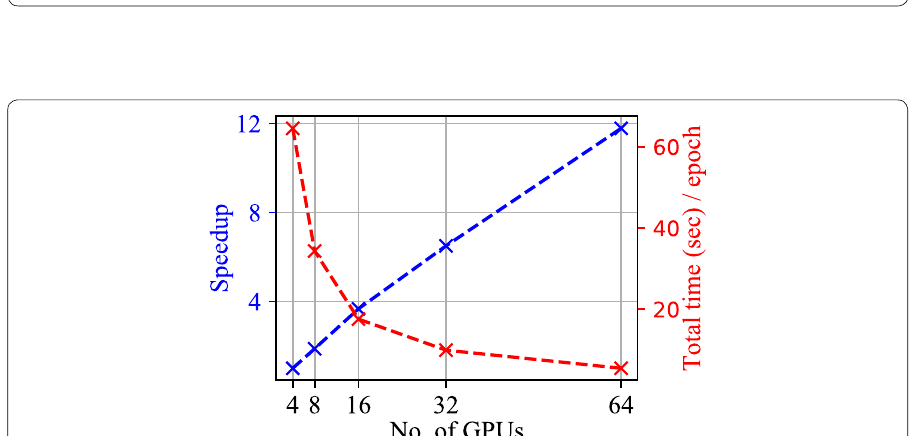
Fig. 4 Cosmology with the HAL Deep Learning Cluster The training stage of a deep learning model, used to morphologically classify galaxies between spiral and elliptical classes, is reduced from 2.1 hours—using a single V100 GPU—to just 2.7 minutes using the entire HAL deep learning